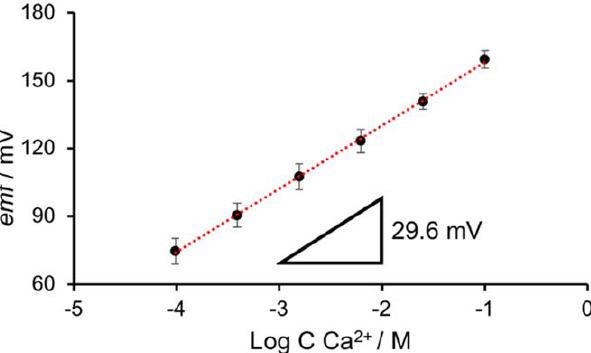
Figure 3. Linear calibration of Ca 2 + -ISEs with a Nernstian response of 28 ± 2 mV Decade − 1 across a range of 100 mM to 97.7 μ M Ca 2 + at pH 7.4. Deviations were calculated across three separate electrodes.